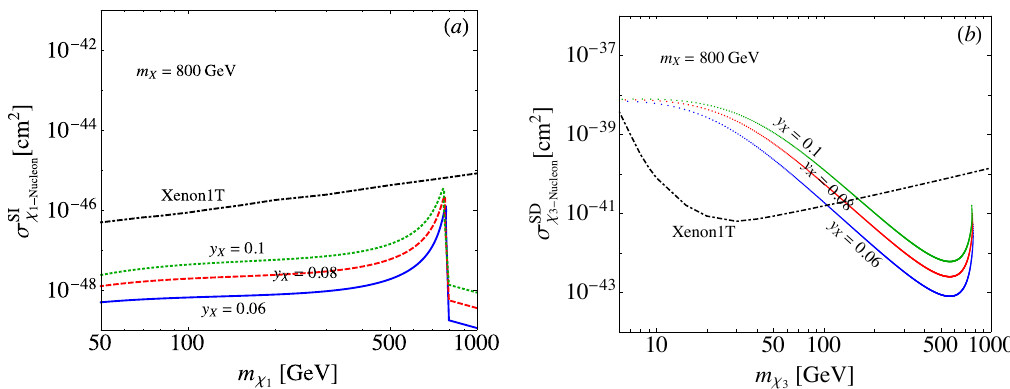
Figure 8 . (a) h -mediated spin-independent and (b) Z -mediated spin-dependent DM-nucleon scat- tering cross sections, where the solid, dashed, and dotted lines denote y X = 0 : 06, y X = 0 : 08, and y X = 0 : 1, respectively, and m X = 800 GeV is used. The dot-dashed lines in (a) and (b) are the Xenon1T results shown in [69,